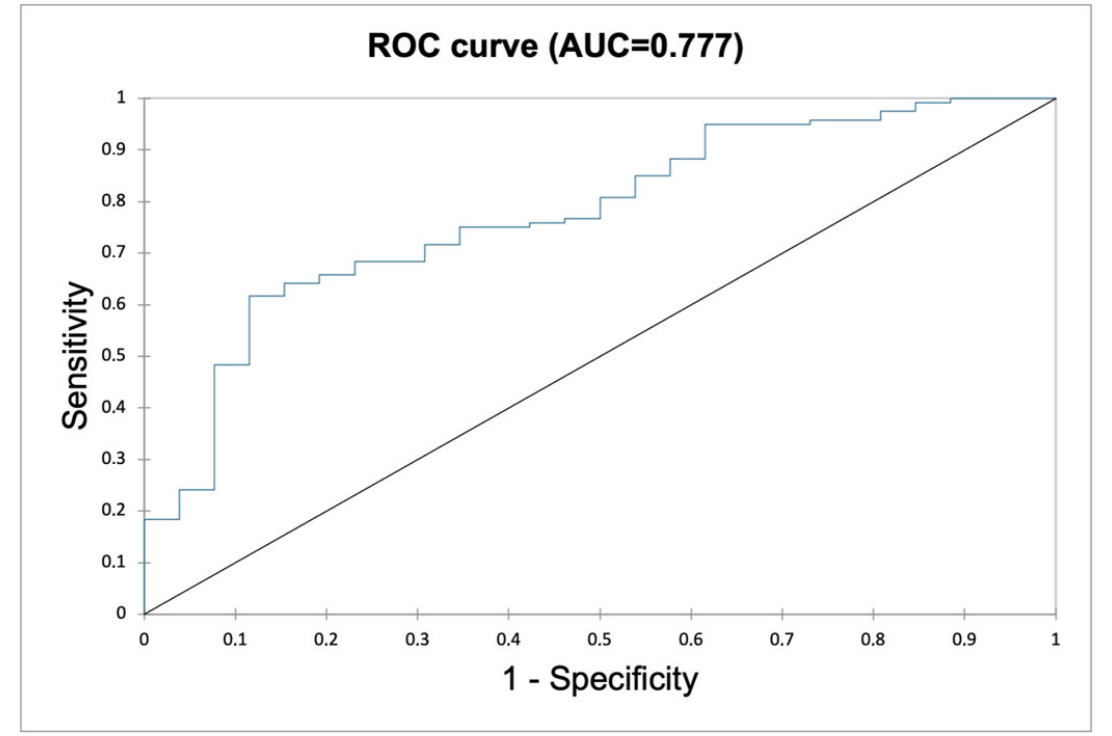
Figure 3. Multivariate model (TMTV + SUV max + age) accuracy.